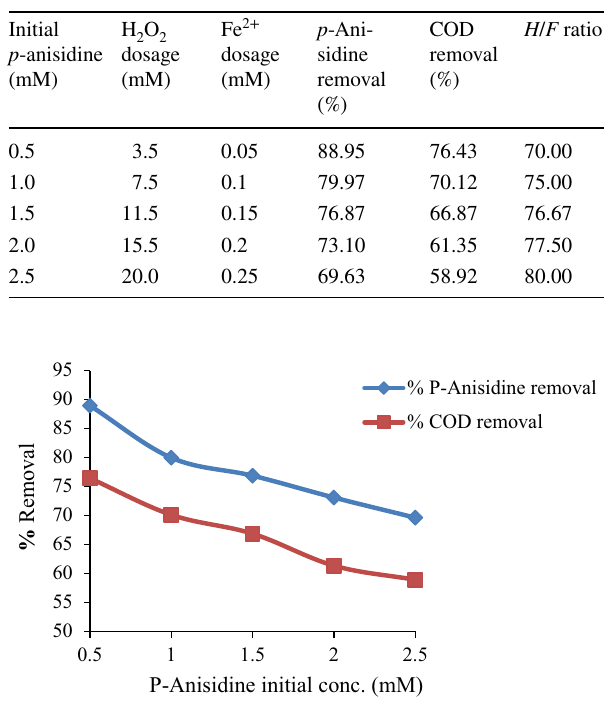
Fig. 6 Effect of varying initial p -anisidine concentration during